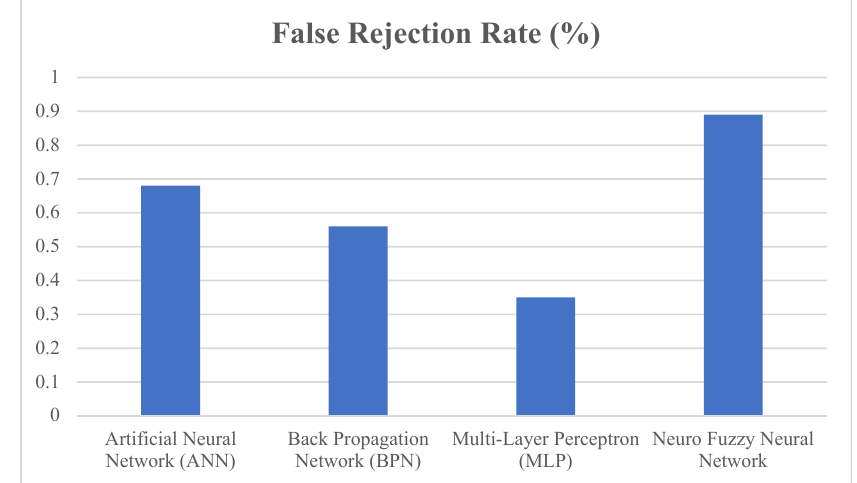
Figure 10. FRR calculation for different classifiers.